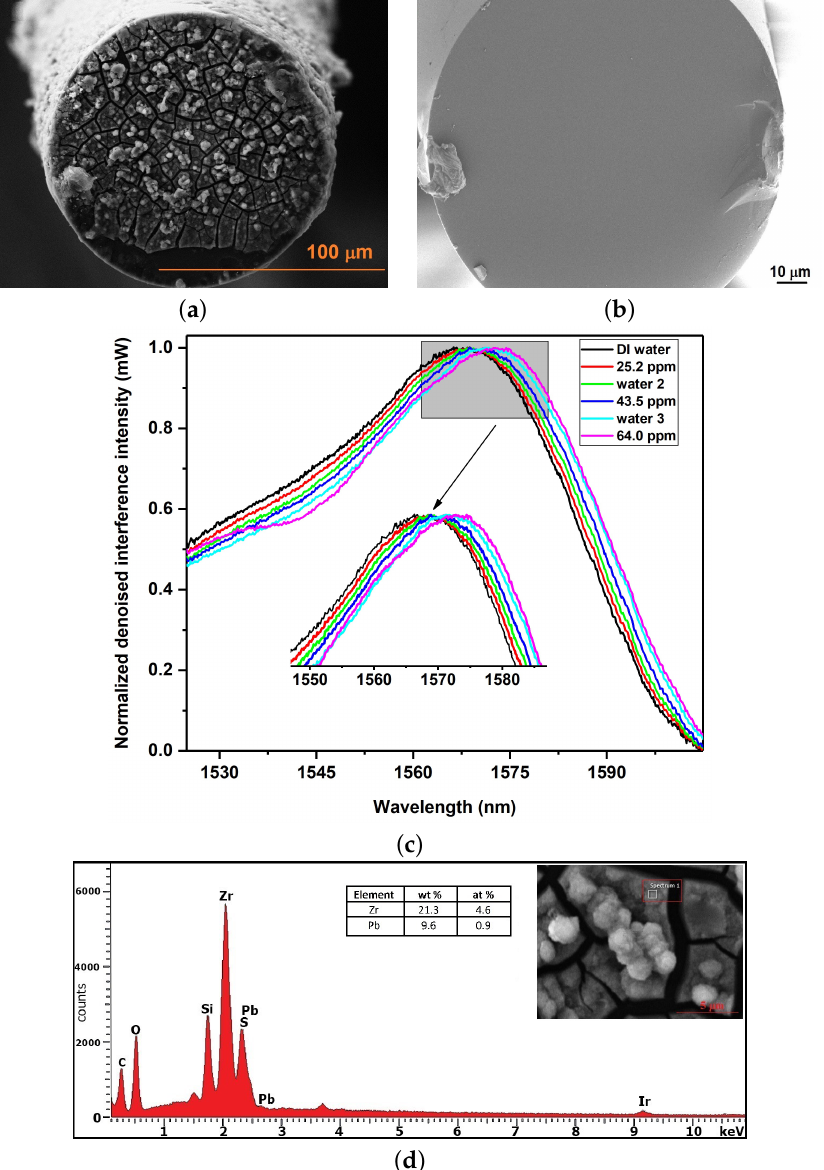
Figure 3. SEM images of ( a ) SO 3 H-UiO-66(Zr) optical fiber sensing element, and ( b ) bare optical fiber, ( c ) Interferograms in correlation with a lead concentration in DI water, and ( d ) EDX spectra of SO 3 H-UiO-66(Zr) optical fiber sensing element after the lead